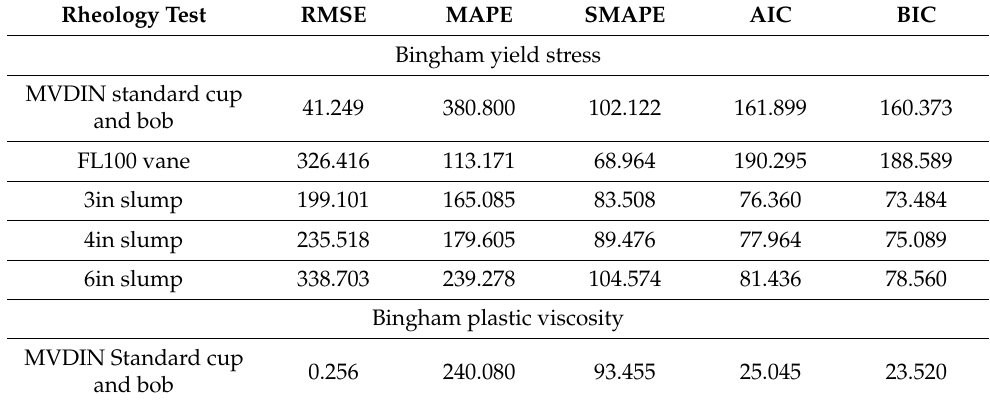
Table 8. Statistical analysis of rheology tests against the loop test experiment for